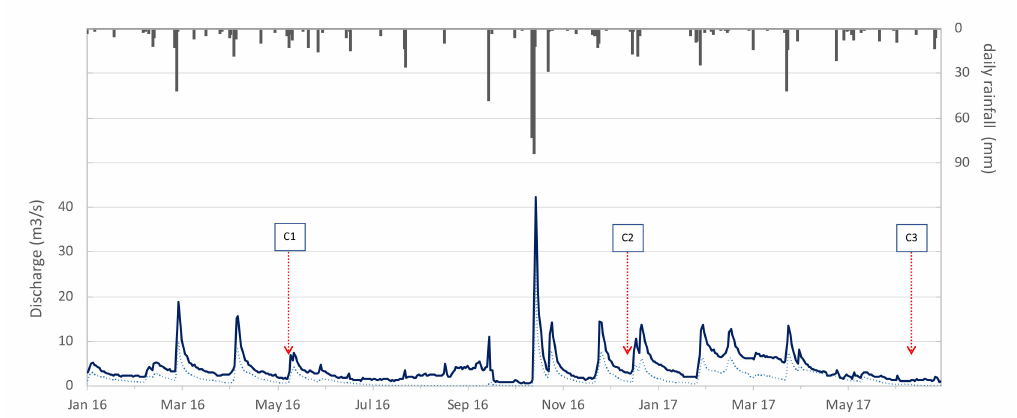
Figure 2. Hydrological conditions in Lez River (dashed line, L2 site, and line, L5 site): Hydrographs and hyetograph from 1 January 2016 to 30 June 2017. Rainfall data (vertical bar) were provided by the Frejorgues Meteo-France weather station and discharges are from DREAL